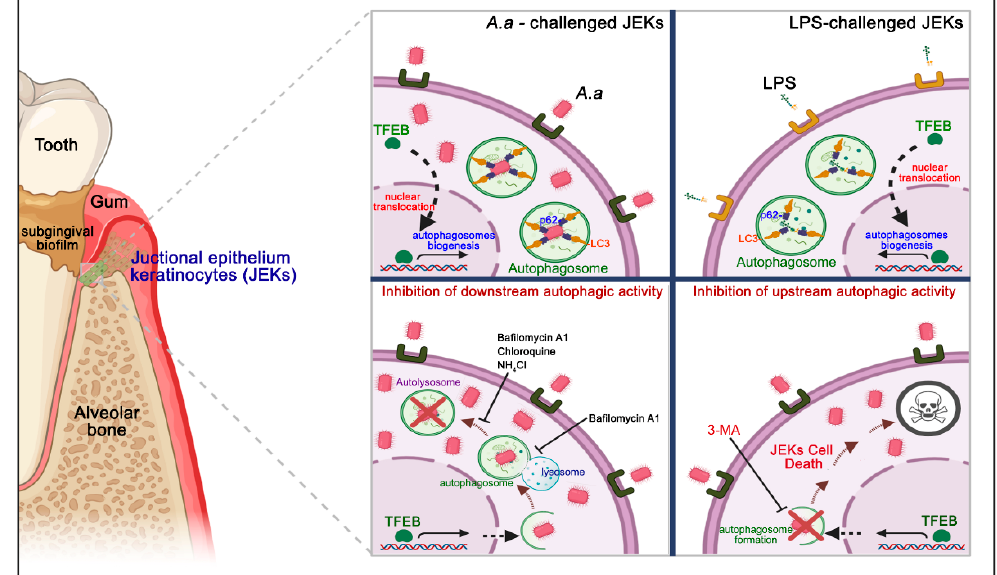
Figure 9. Schematic representation of the junctional epithelium keratinocytes-autophagy induced by A. actinomycetemcomitans infection. The junctional epithelium represents the main site of the initial interaction between the dysbiotic subgingival biofilm and host. The challenge and binding of A. actinomycetemcomitans and its purified LPS on JEKs surface triggers TFEB translocation to the nucleus and autophagosomes biogenesis. Bacteria and LPS internalized are sequestered to the autophagosomes in formation, through recruitment to the p62-cargo adapter protein, and interact with LC3 protein, favoring autophagy activation (upper panel). Treatment with the alkalinizing compounds of lysosomes bafilomycin A1, chloroquine, and NH 4 Cl, which inhibit the late stages of autophagic flow, induced intracellular bacteria accumulation and significantly increased the infected-JEKs number (lower left panel). Inhibition of autophagosome biogenesis with 3-MA induces cell death in JEKs challenged with A. actinomycetemcomitans or its purified LPS in the initial stage of infection (lower right panel). This figure was designed using BioRender.com.